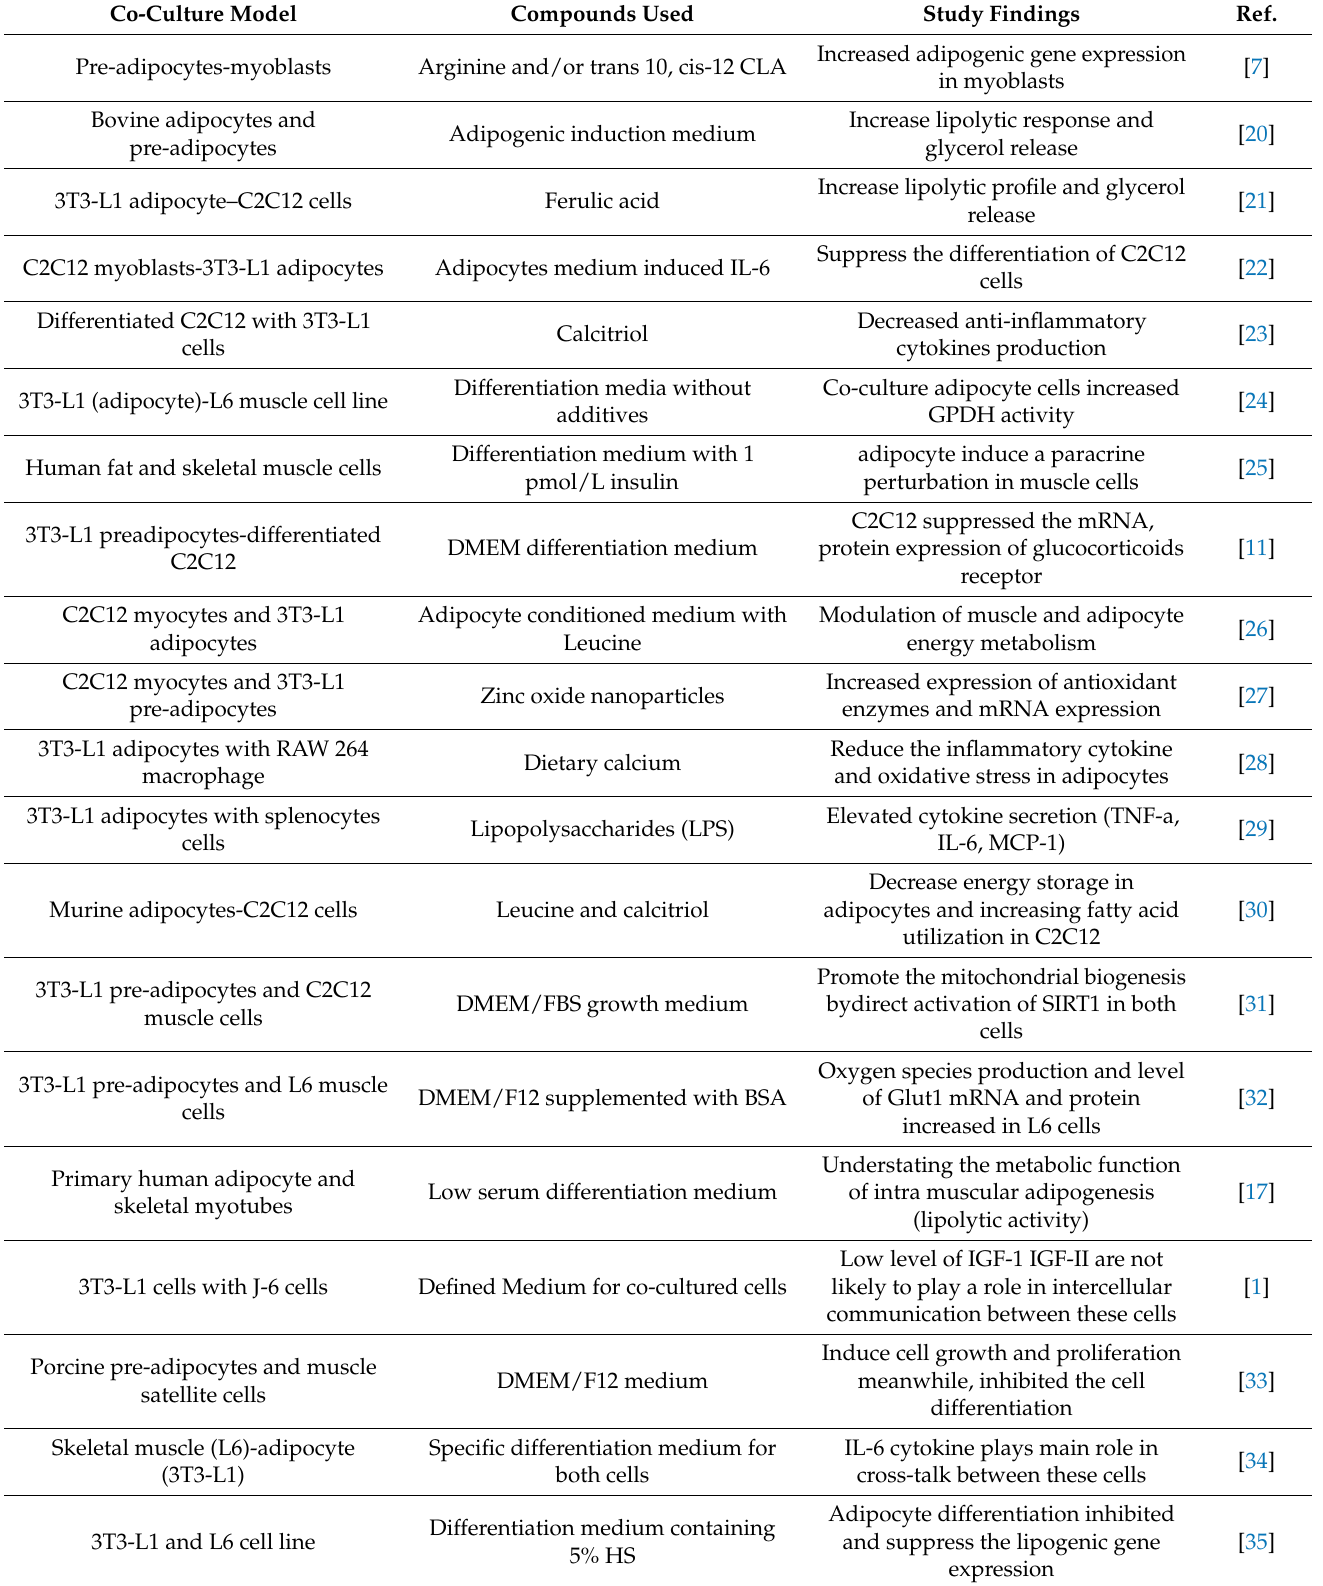
Table 1. Examples of co-culture model systems consisted of adipose and muscle